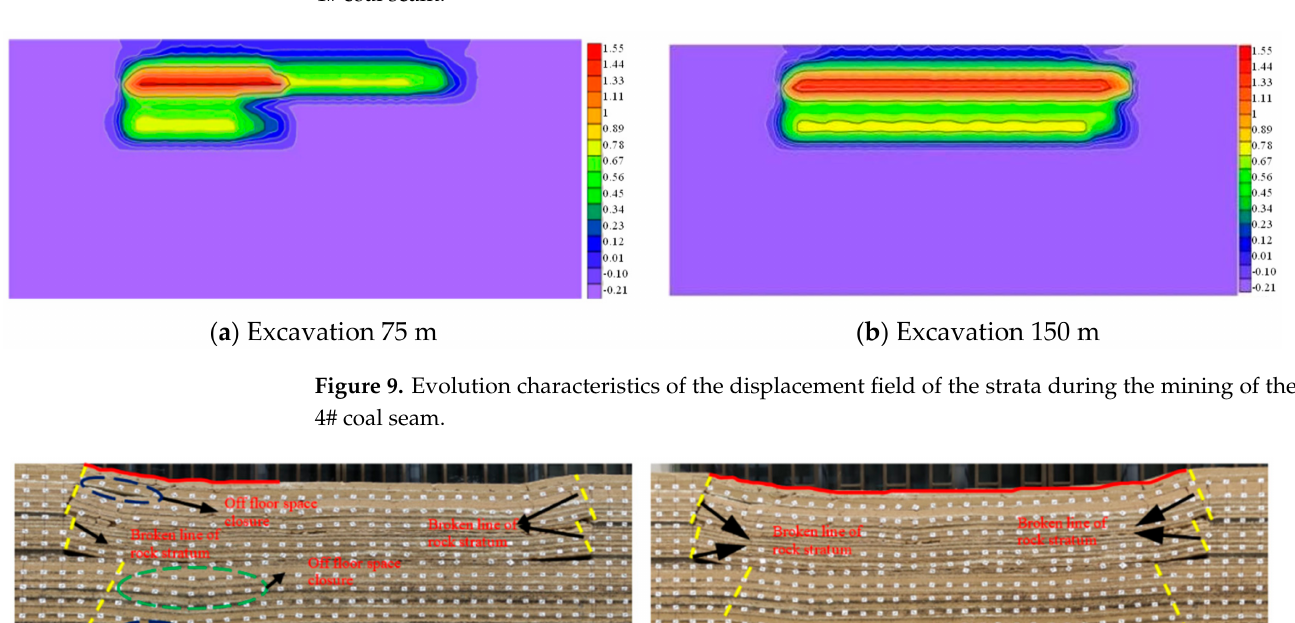
Figure 8. Characteristics of overburden movement and deformation during the mining of the 4# coal seam.